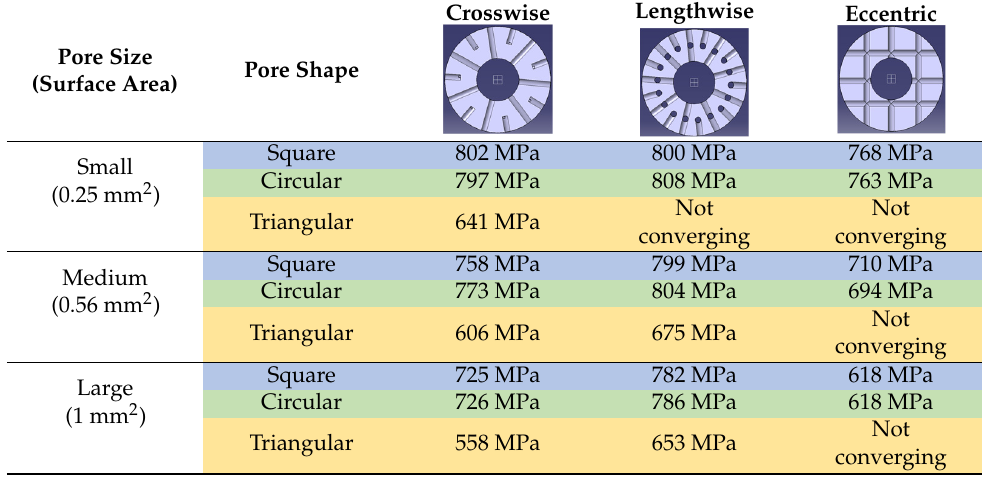
Table 2. Rigidities in MPa for each model with their simulated compression load (FEA).